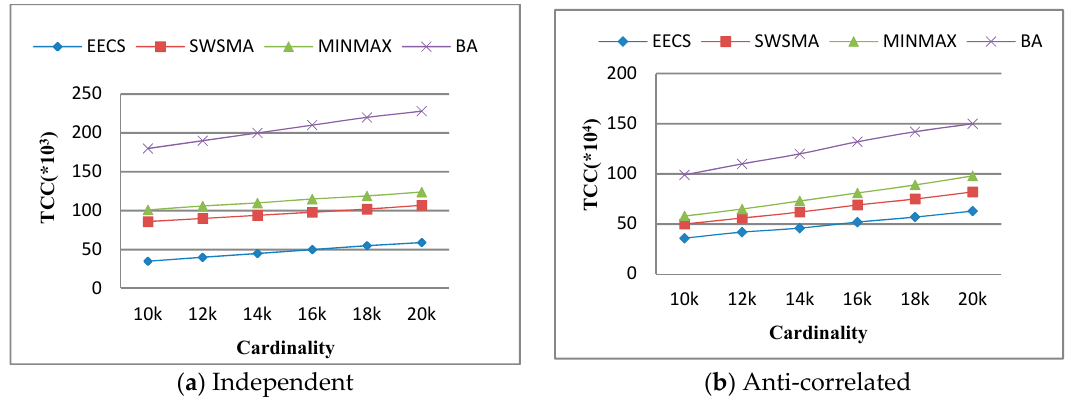
Figure 5. Performance vs. cardinality.